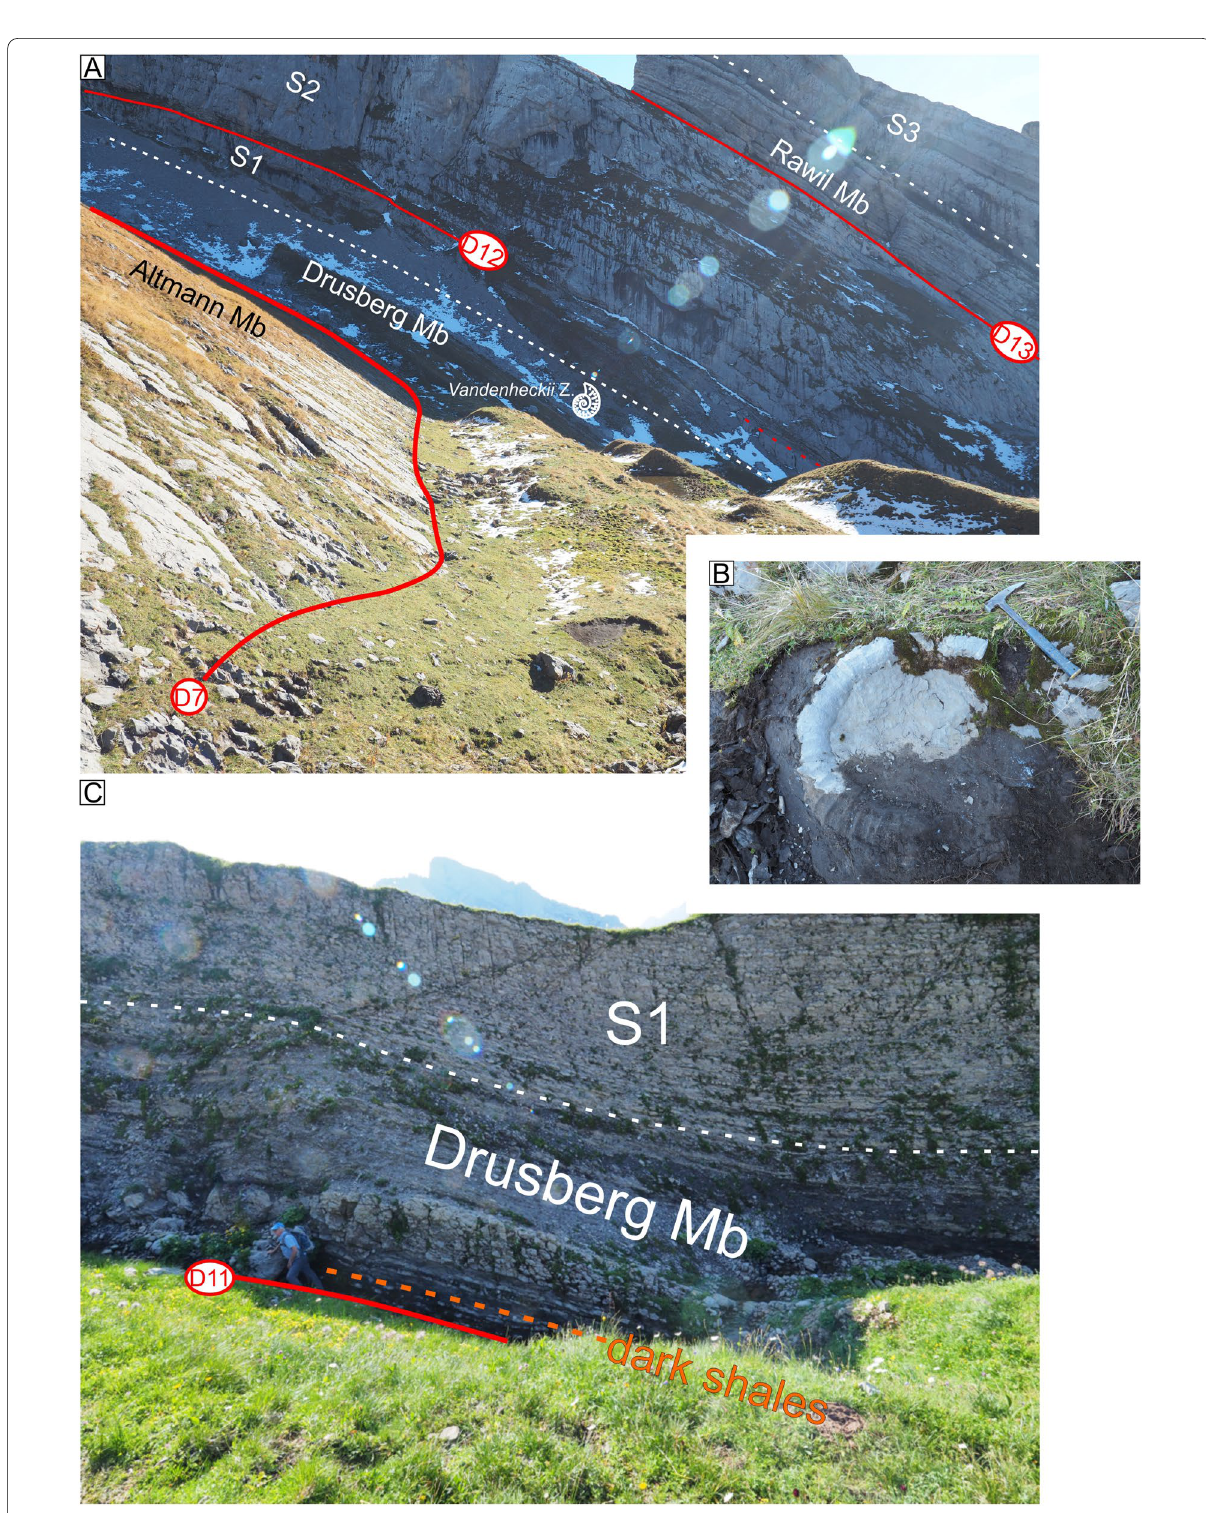
Fig. 6 A Overview of the Langtal outcrops and of the Gir cliff on which the main lithostratigraphic units and discontinuity surfaces are reported. B Focus on the giant heteromophic ammonite Honnoratia thiollierei (Astier, 1851) in the uppermost metre of the Altmann Member. C Focus on the progressive facies transition between the Drusberg Member and the Schrattenkalk